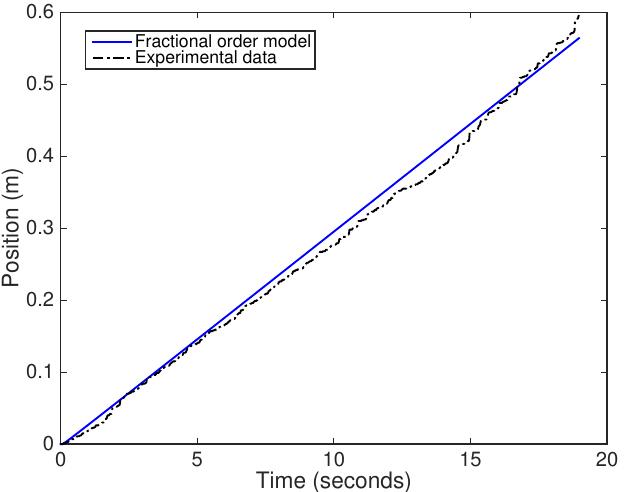
Figure 5. Position experimental data compared to the identified positioning model for the non- Newtonian